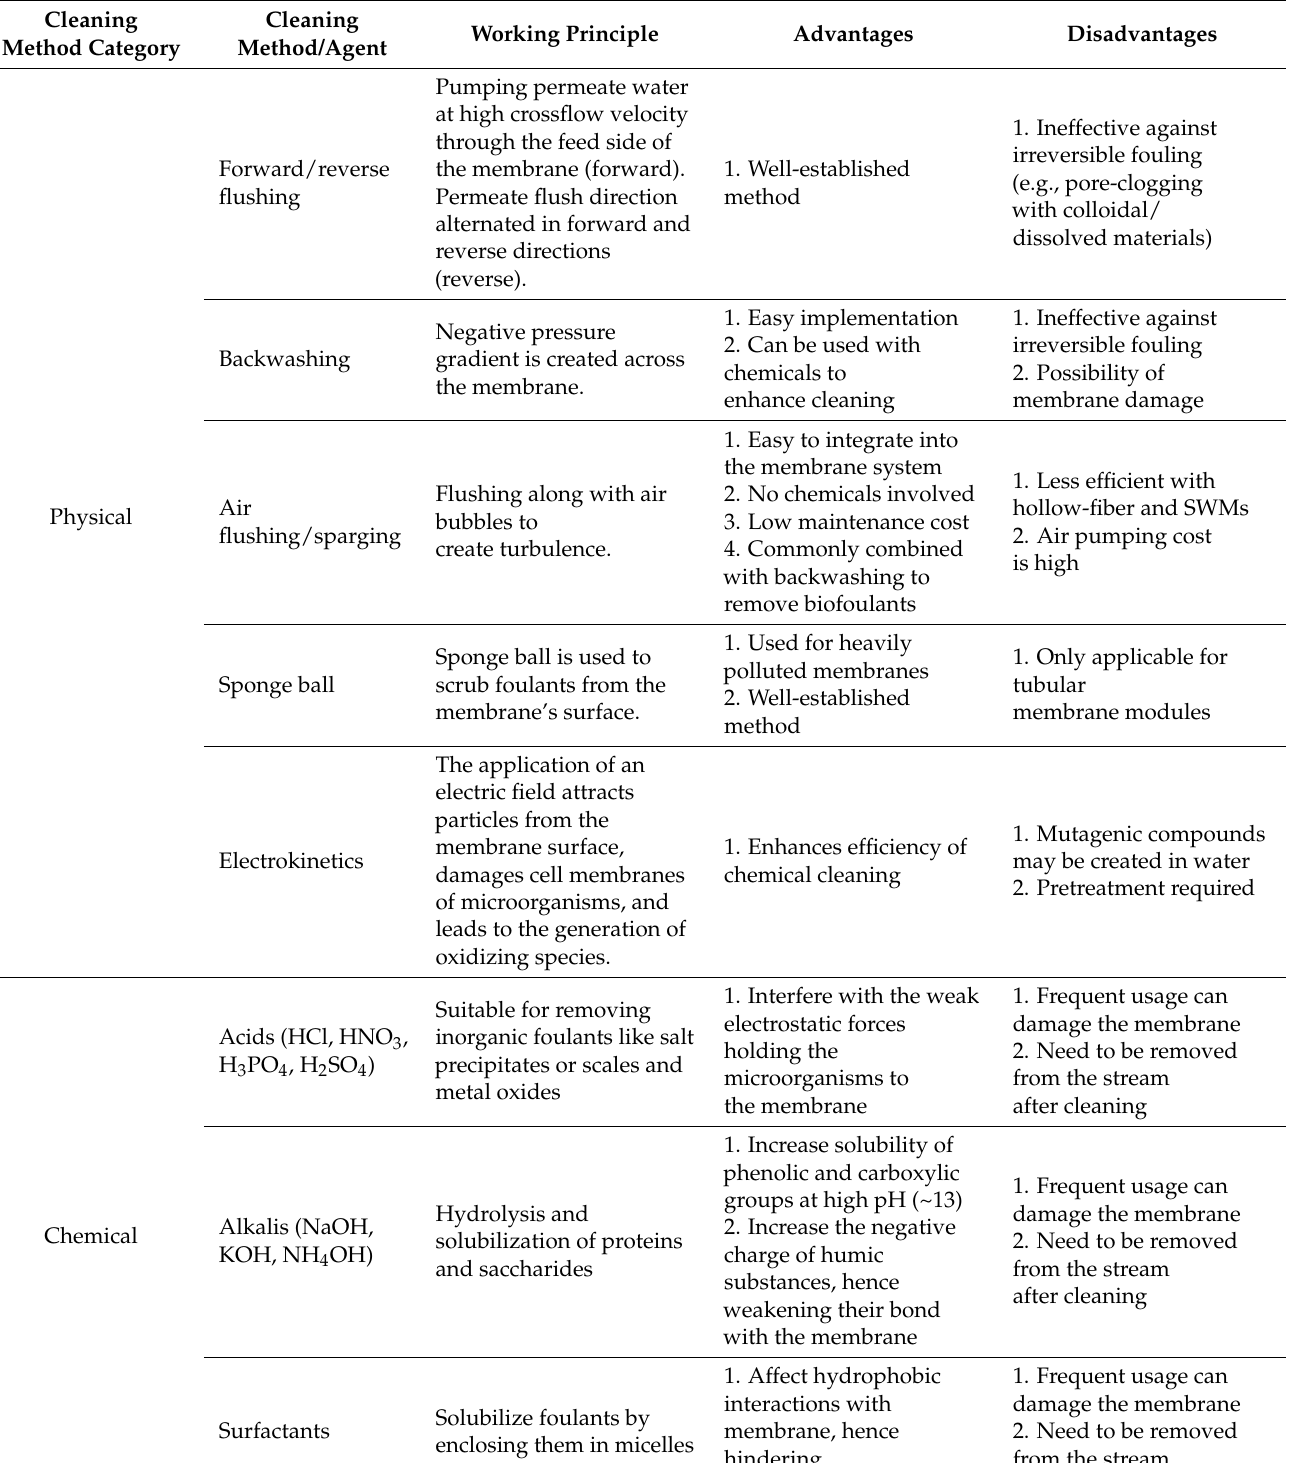
Table 5. Comparison of chemical, physical, and nonconventional membrane cleaning methods (adapted from